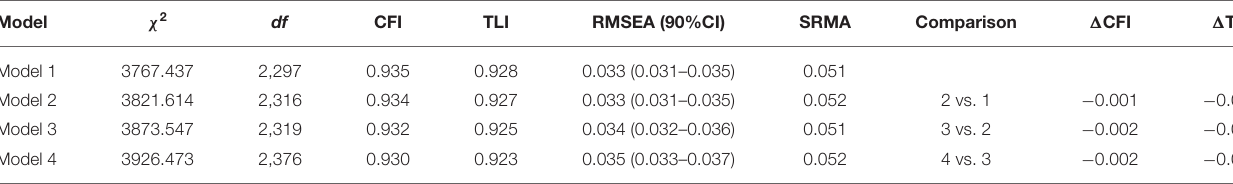
TABLE 8 | Measurement invariance of the CERQ-C across time. Model